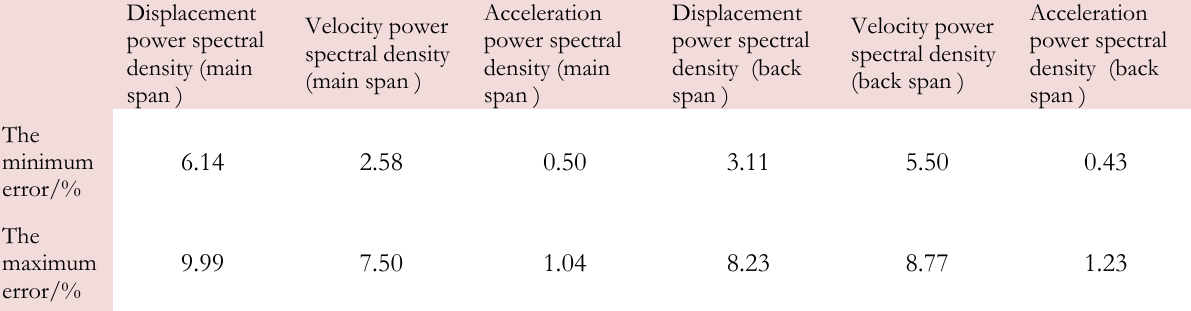
Table 1: The error comparison for two